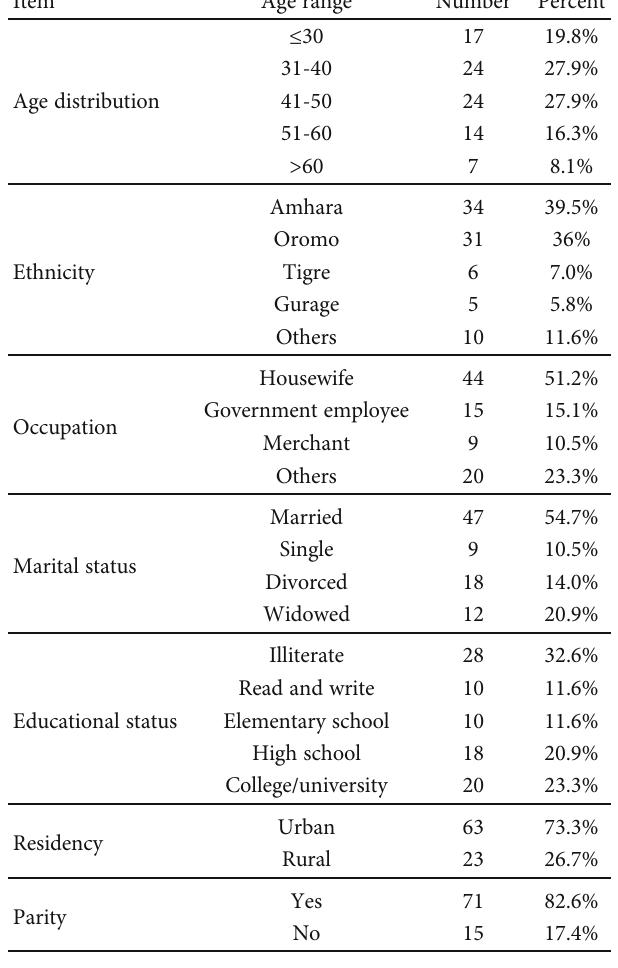
Table 1: Sociodemographic characteristics of female breast cancer patients, mastectomy-related quality of life (SPHMMC, Addis Ababa, Ethiopia, 2018).